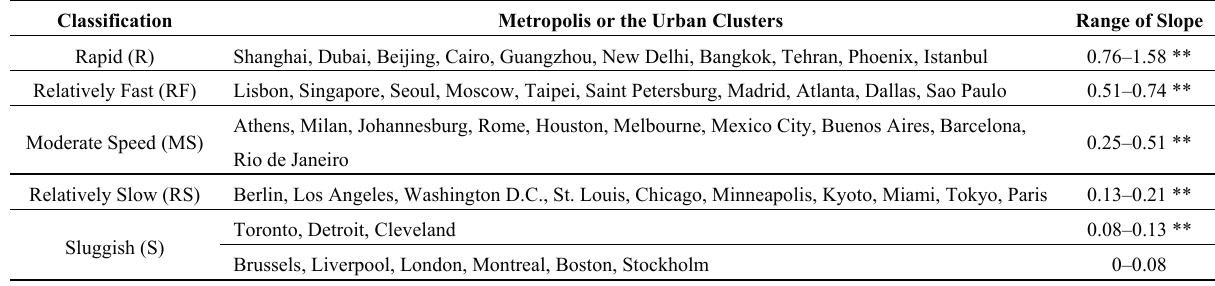
Figure 6. Urban expansion in several samples from 1992 to 2012. The definition of urbanization threshold is DN ≥ 50 after calibration, and the extent in the layout is only for the core area of the metropolis or the urban clusters. Guangzhou signifies the Pearl River Delta urban clusters. Table 4. Classification of the urbanization trend of metropolises during 1992–2012. Each class has 10 cities in a high-low slope